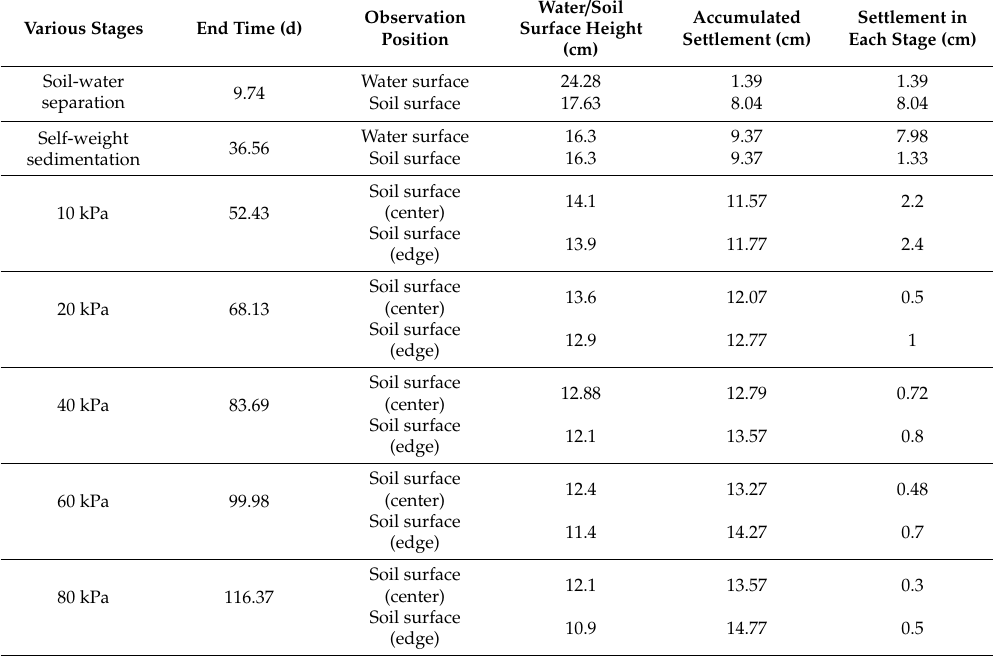
Figure 5. Time-dependent settlement curves in different stages. Table 4. Soil sampling and testing schemes.